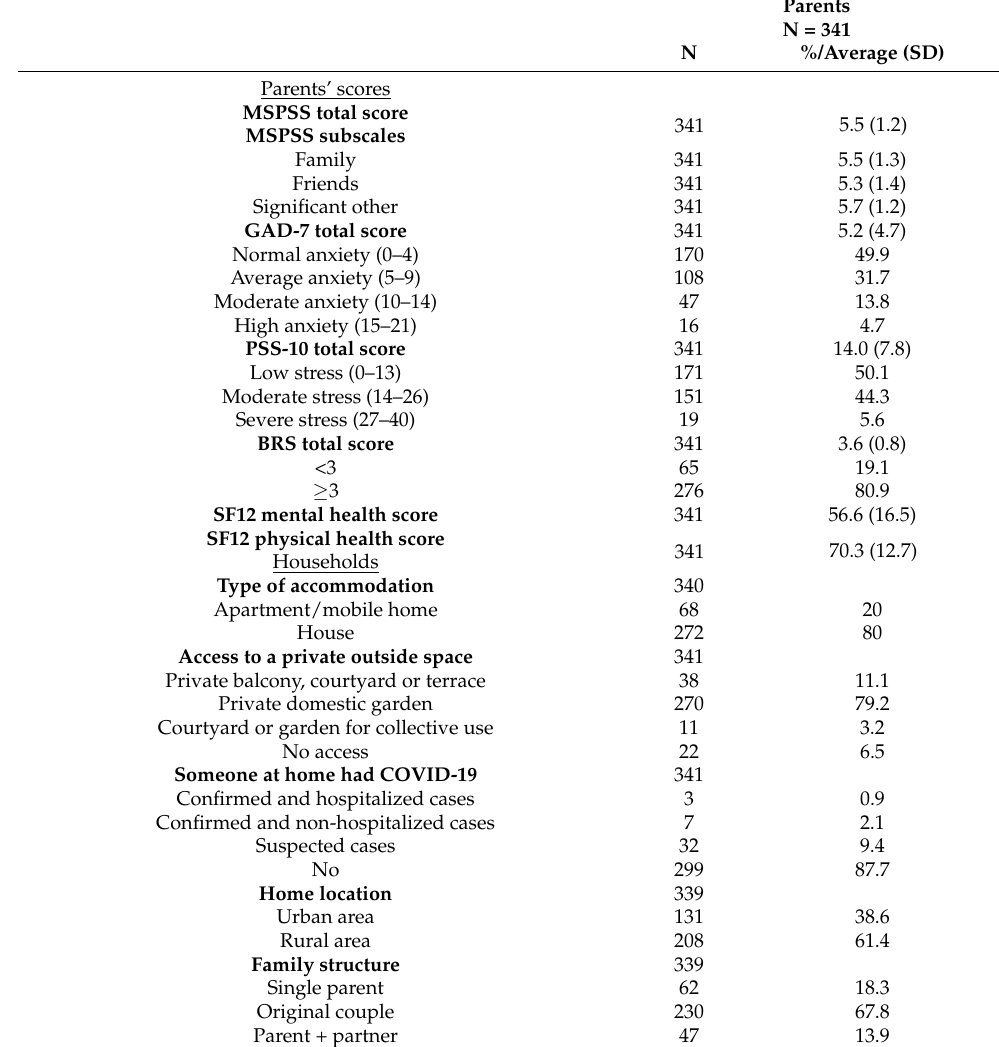
Table 3. Household characteristics and parents’ scores on the various